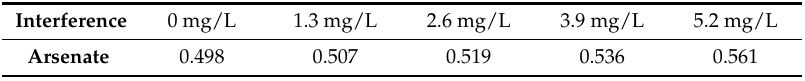
Table 2. The estimation on the interference of arsenate with different concentrations.